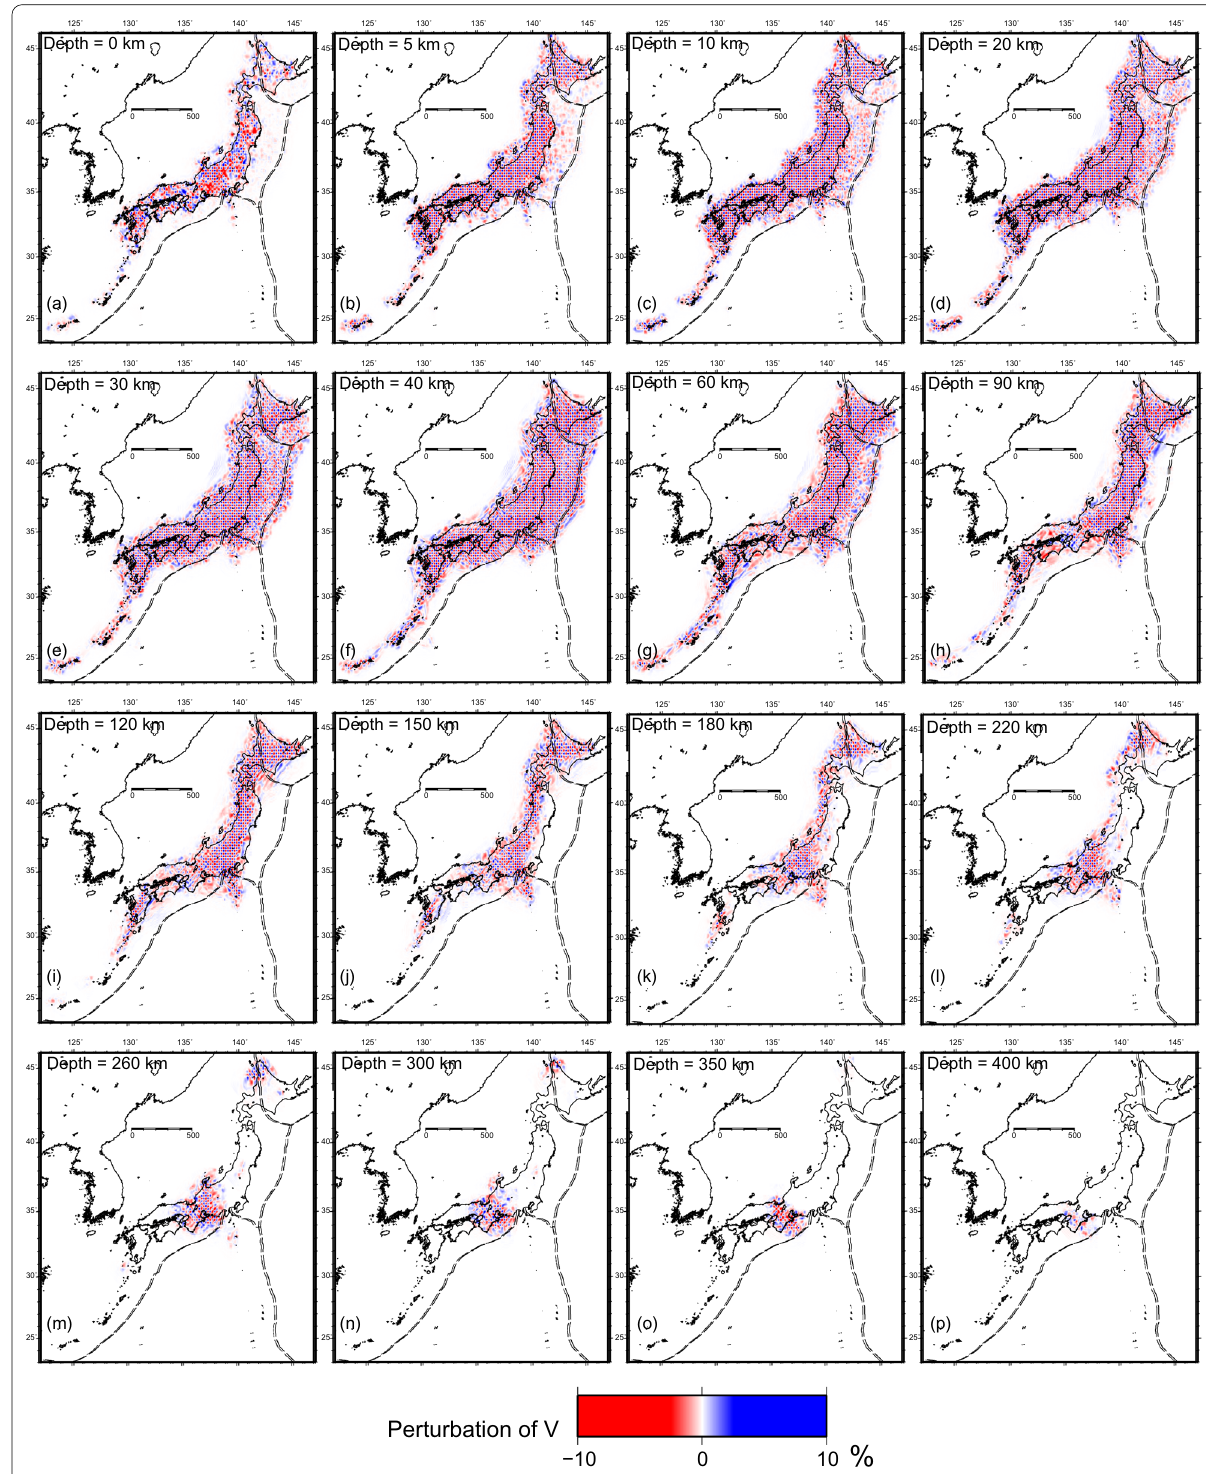
Fig. 8 Result of checkerboard resolution test for